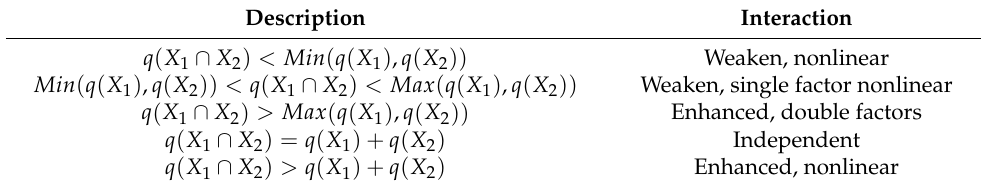
Table 3. Types of interaction between two